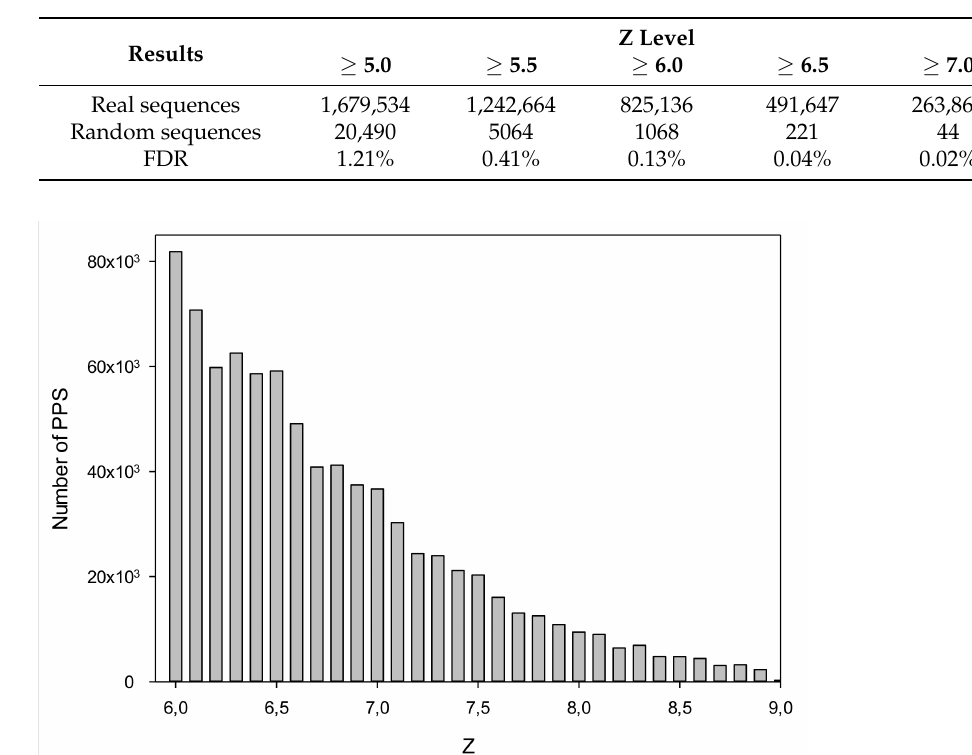
Table 2. Number of PPSs in the C. annuum genome for different Z 0 levels.